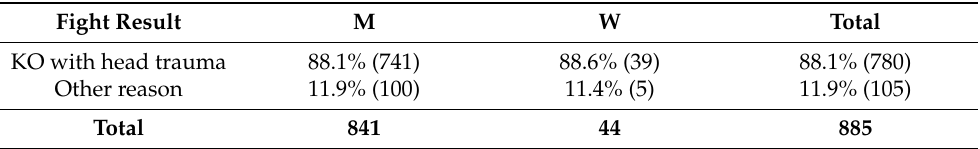
Table 3. Fights ended due to the KO with head injury versus all fights divided by male and female